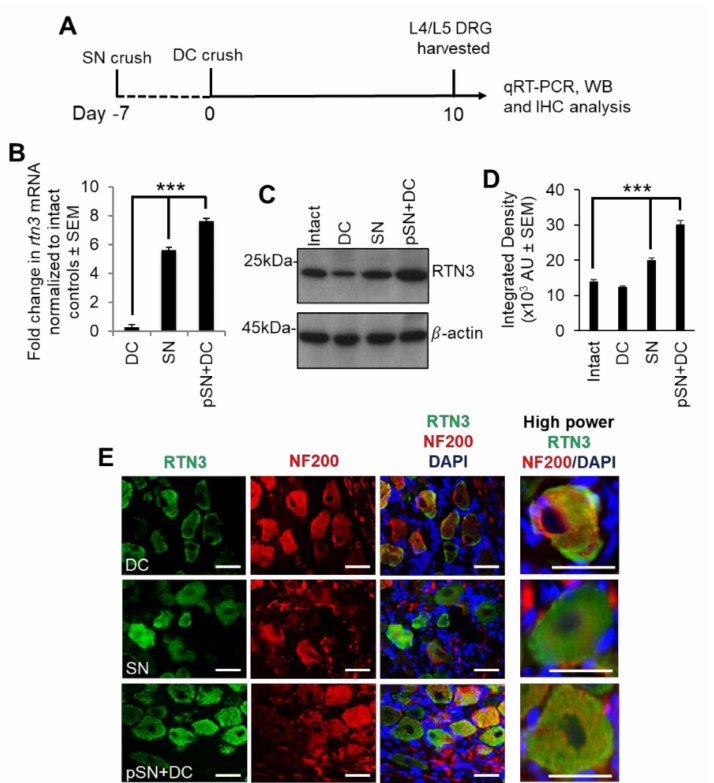
Figure 1. RTN3 is upregulated in dorsal root ganglion neurons (DRGN) after preconditioning lesions. ( A ) The diagram shows the timeline of treatments and tissue harvesting. ( B ) qRT-PCR to confirm upregulated RTN3 mRNA in SN and pSN + DC injury models ( n = 16 DRG/group (8 rats/group)). ( C ) Western blot to show levels of RTN3 in control, DC, SN and pSN + DC injury models ( n = 16 DRG/group (8 rats/group)). ( D ) Densitometry to confirm upregulation of RTN3 in SN and pSN + DC injury models ( n = 16 DRG/group (8 rats/group)). ( E ) Immunohistochemistry to show immunolocalisation of RTN3 (green) in DRGN (red). Data are means ± SEM. Scale bars in ( E ) = 50 µ m. *** p = 0.0001, one-way ANOVA with Dunnett’s post hoc